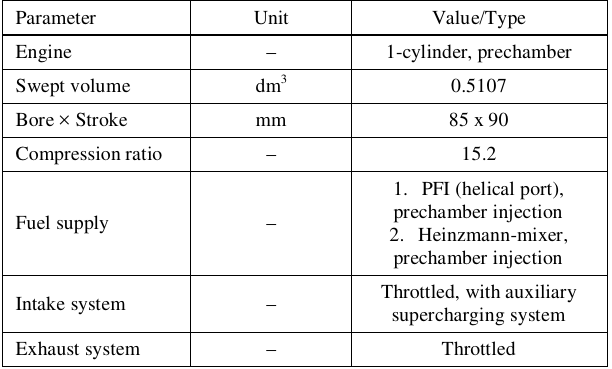
Table 2. Technical parameters of AVL 5804-engine